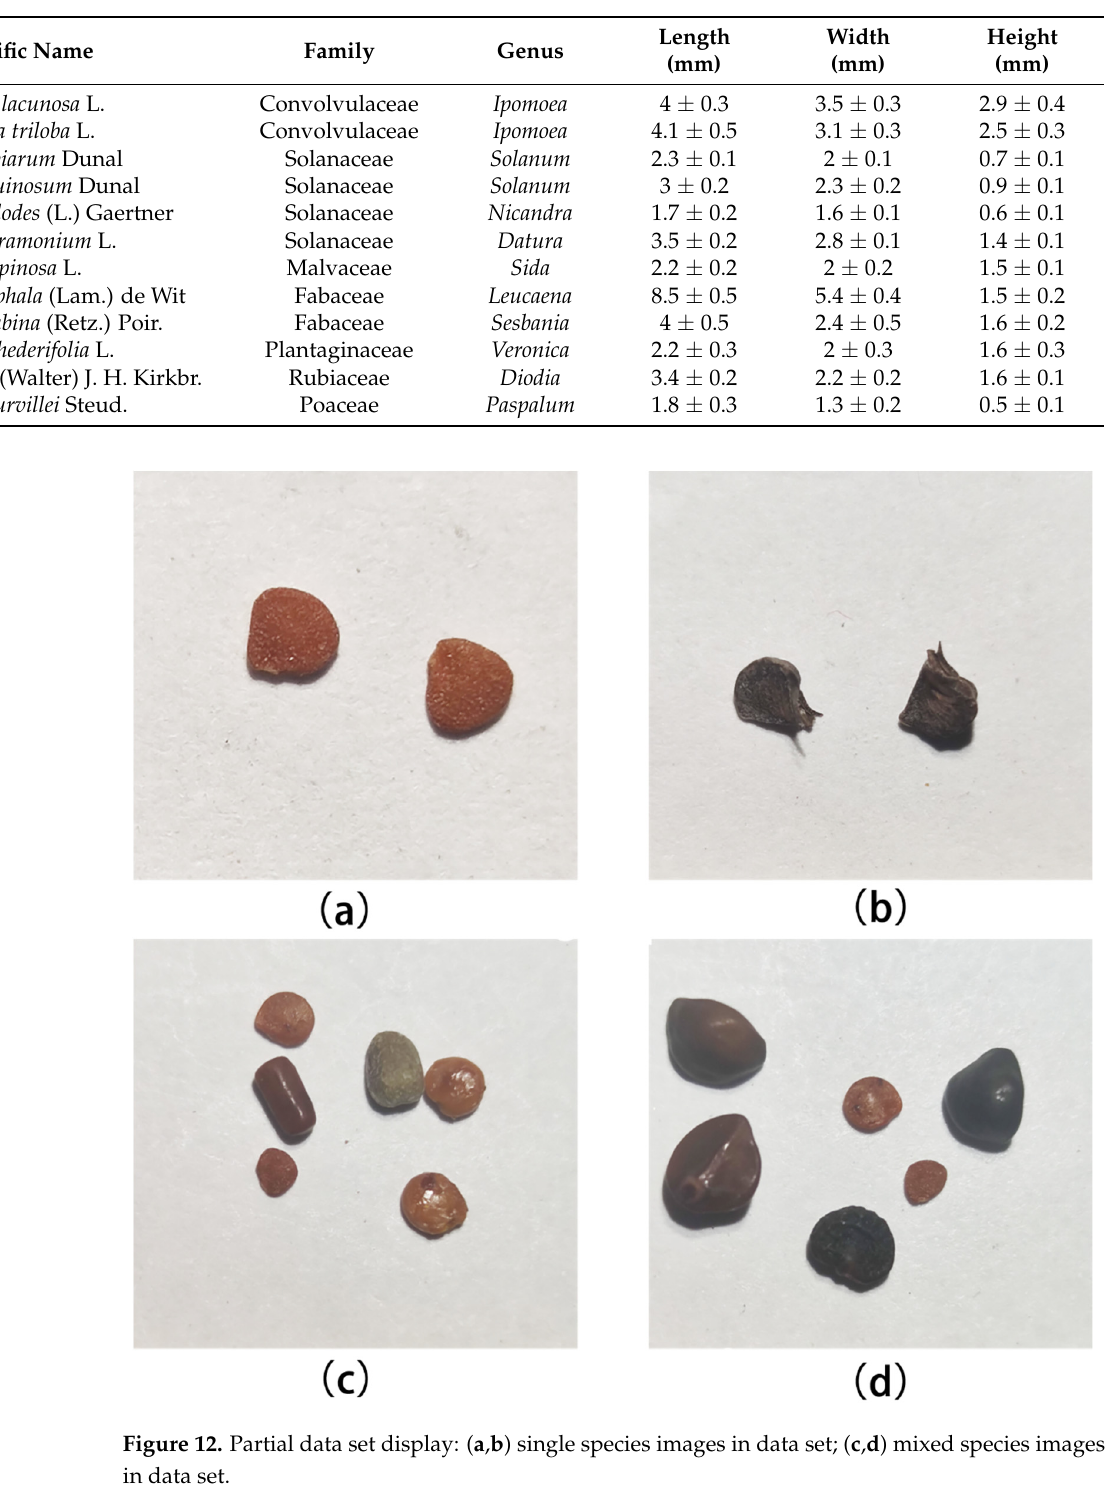
Table 2. Details of 12 species in the data set: including family and genus information of the species and average data of seed length, width, and height of the species.